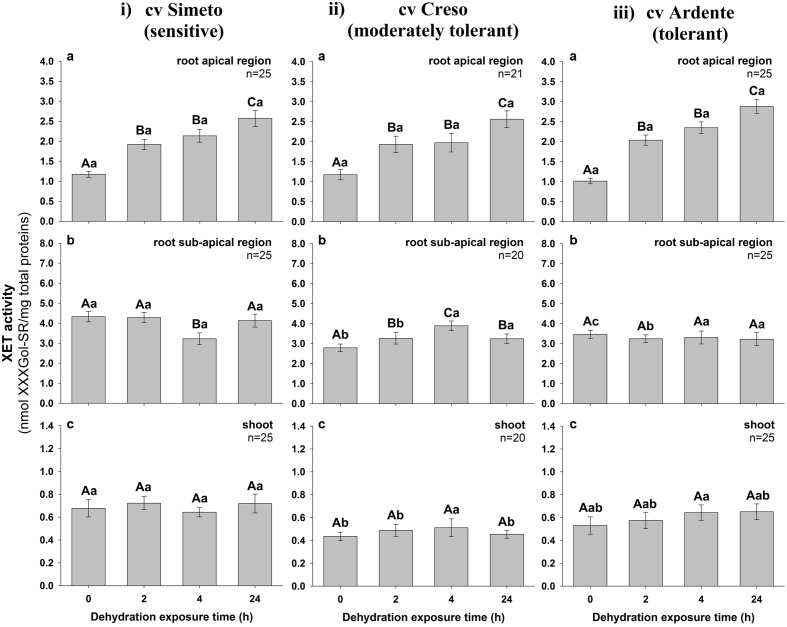
Extractable XET activity in excised segments of (a) root apical region, (b) root sub-apical region, and (c) shoot from 3-day-old durum wheat (T. durum Desf.) seedlings of (i) Simeto, (ii) Creso, and (iii) Ardente cultivars, differing in dehydration tolerance. The seedlings of each cultivar were subjected to drought stress for 2, 4, and 24 h. XET activity is expressed as nmol of xyloglucan–XXXGol-SR formed by the transglycosylation reaction, per mg of total protein. The results represent the average of n independent replications ± standard error. Different capital letters above bars indicate statistically significant differences (p < 0.05) between time points within the same cultivar, while lower case letters indicate statistically significant differences across cultivars in response to stress duration, as determined by the Tukey’s post hoc test.